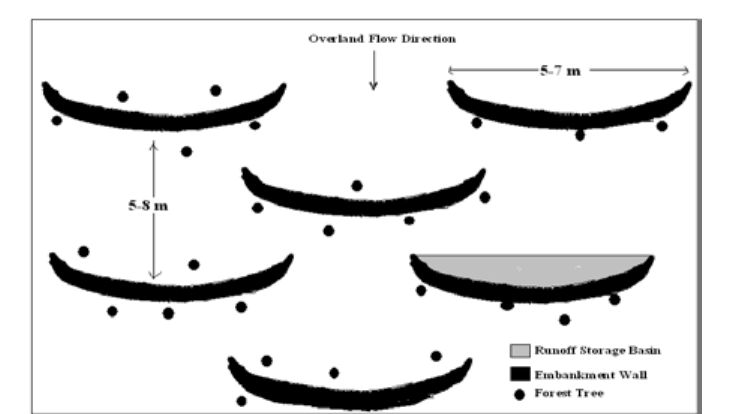
Fig. 3: Schematic map of semi-circular bund in the study area